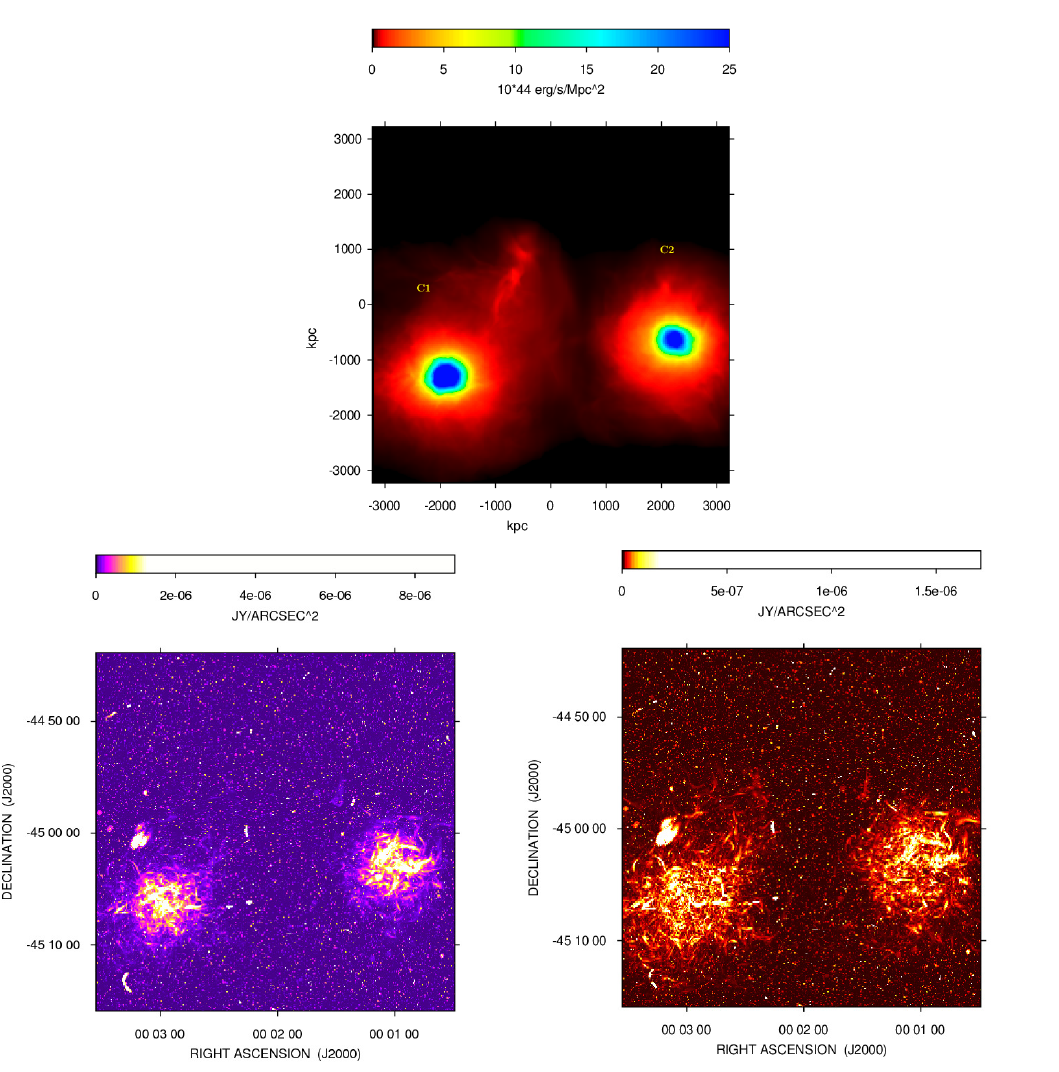
Figure 1. ( a ) X-ray surface brightness of a pair of galaxy clusters at redshift z = 0.205, in a field of view of ∼ 6.4Mpc with a spatial resolution of ∼ 10.7kpc; ( b ) total intensity surface brightness at 1.4GHz of the cluster-embedded, foreground and background discrete radio sources plus the cluster radio halos; ( c ) polarized intensity surface brightness at 1.4GHz of the cluster-embedded, foreground and background discrete radio sources plus the cluster radio halos. The beam Full-Width-at-Half-Maximum (FWHM) for images ( b , c ) is equal to 2.5 (cid:48)(cid:48) , while the field of view is ∼ 0.3deg 2